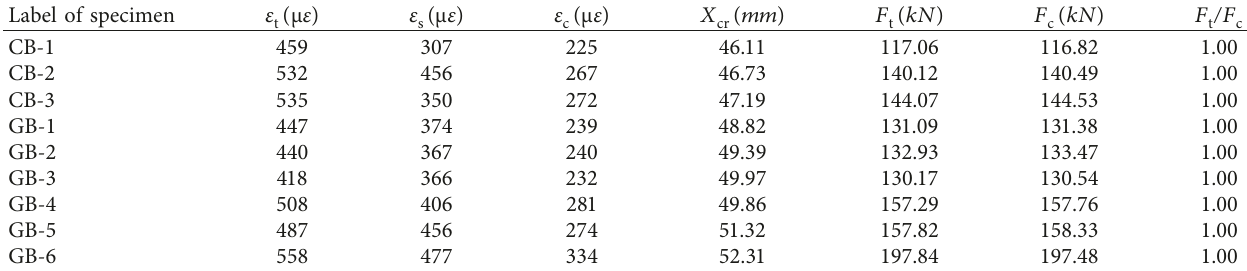
Table 11: Calculation of internal equilibrium of the stone slab.